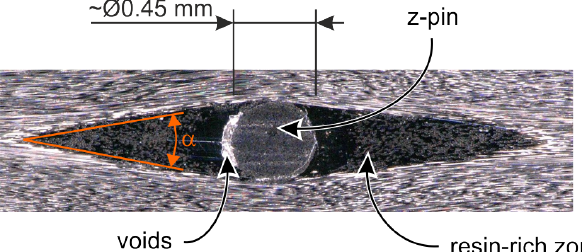
Figure 3. Cross-sectional view of an unidirectional z-pinned laminate reinforced with circumferentially notched z-pins with a rectangular notch design and a notch depth of 25 µ m. The sectional plane is located in the area of a